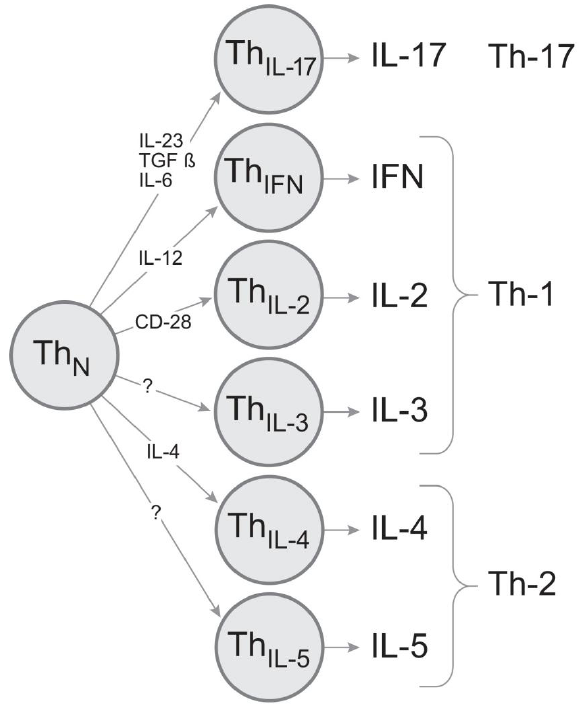
Figure 6. Proposed model for CD4 cell cytokine sublineages. The production of each